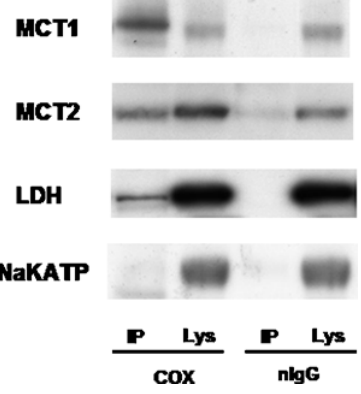
Figure 7. Antibodies to COX and normal IgG (nIgG) were used to develop immunoprecipitates (IP) from Tween 20 (1%)- solubilized mitochondrial fractions of brain tissue. IP proteins were subsequently probed with antibodies to MCT1, MCT2, LDH, and b 1 -Na + -K + -ATPase. MCT1 and MCT2 were coprecipitated with COX, and LDH was slightly, but significantly coprecipitated with COX as compared to nIgG (no protein was coprecipitated with nIgG). The plasma membrane marker b 1 -Na + -K + -ATPase was not coprecipitated with either COX or nIgG. Sup, supernatant after immunoprecipitation in lysates of mitochondrial